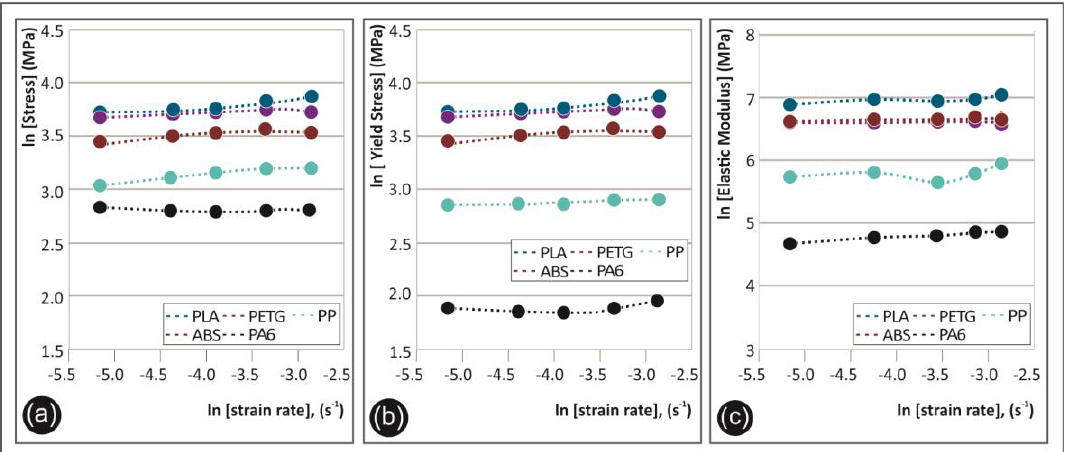
Figure 13. ln(x) to ln (strain rate), (s − 1 ) for all five polymers tested, where x = ( a ) maximum tensile stress (MPa), ( b ) yield stress (MPa), and ( c ) tensile modulus of elasticity (MPa).